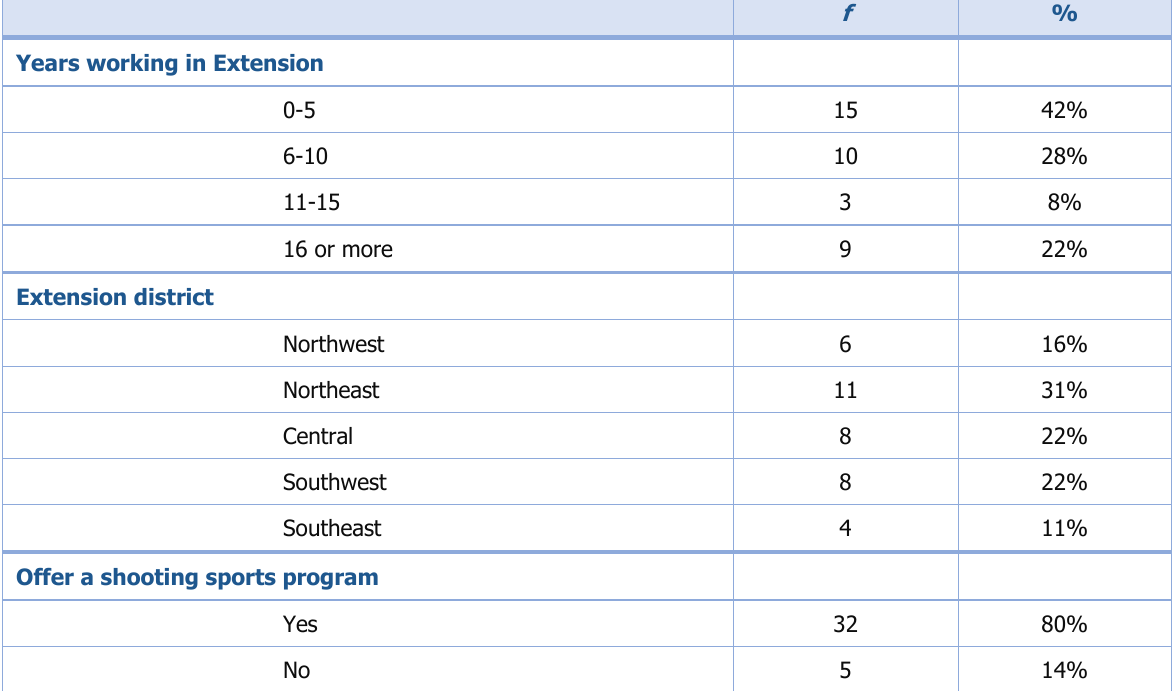
Table 1. Demographic Characteristics of Respondents